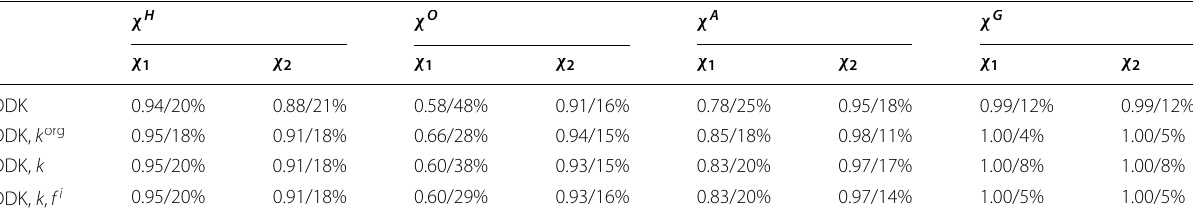
Table 1 Correlation coefficients and relative standard deviations (RSD) in percentage of the polar motion excitation functions for the continental hydrosphere χ H , oceans χ O , Antarctica χ A and Greenland χ G derived from simulated noisy GRACE gravity field solutions using the DDK filter or by applying the DDK filter in combination with the global grid point gain factors k org or k (inclusive scaling factors f i ), respectively, with respect to polar motion excitation functions derived from true GRACE gravity field